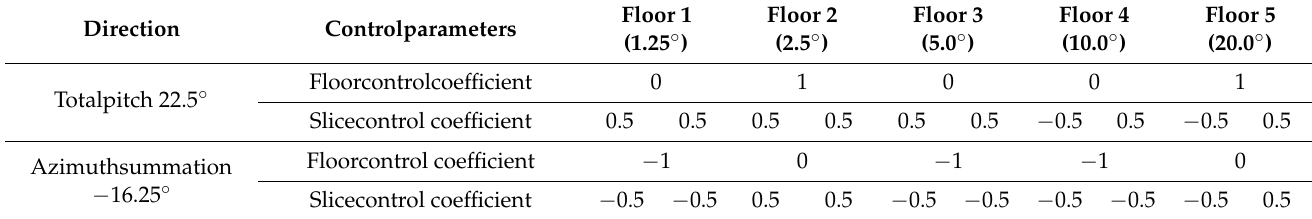
Table 1. Layer control coefficient and plate control coefficient of adjustable liquid crystal half- wave plate.